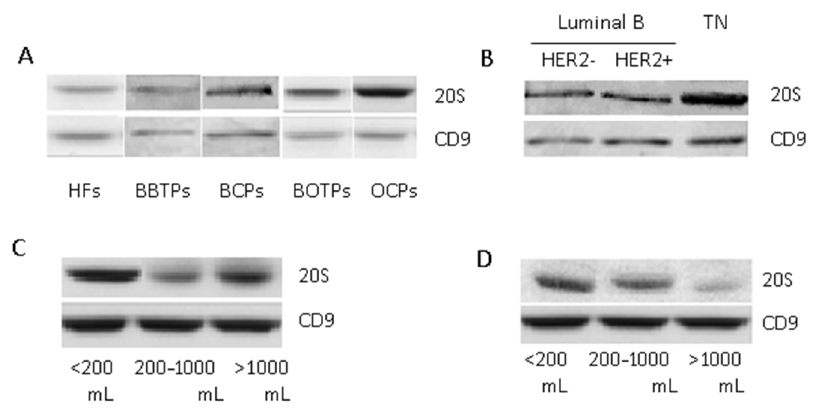
Figure 4. The 20S proteasome level in exosomes from plasma and ascites of tumor patients compared to healthy females, detected by Western blot. Western blotting was performed using antibodies against α & β subunits of 20S proteasome. CD9 was used as the internal control. ( A ) Plasma exosomes from HFs and patients with breast and ovarian tumors; ( B ) plasma exosomes from BCPs with Luminal B or TN molecular subtypes; ( C ) ascites exosomes from OCPs in depending on ascites volume; ( D ) plasma exosomes from OCPs in depending on its volume.